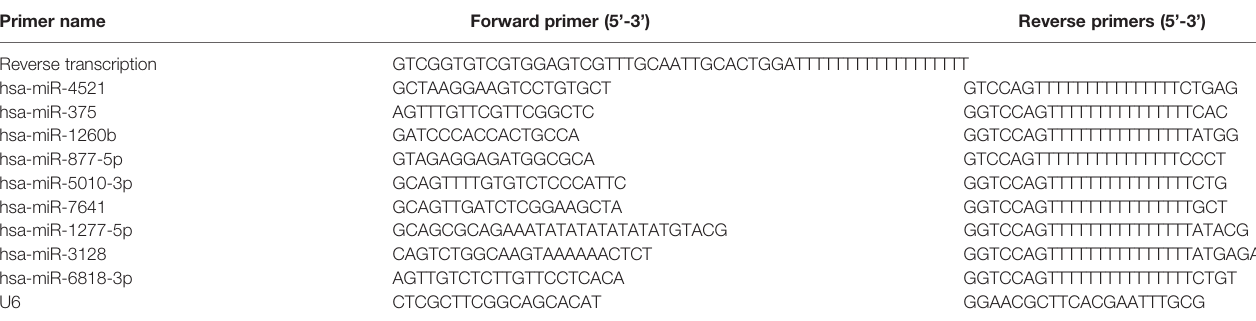
TABLE 1 | Primers for analysis of miRNA expression by